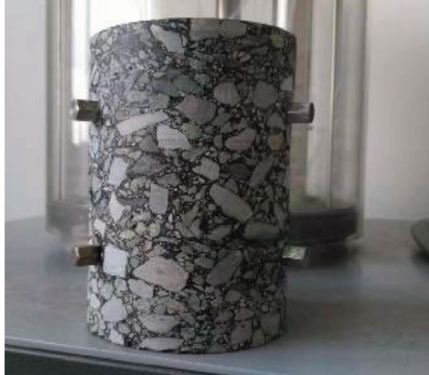
Figure 10: SPT test